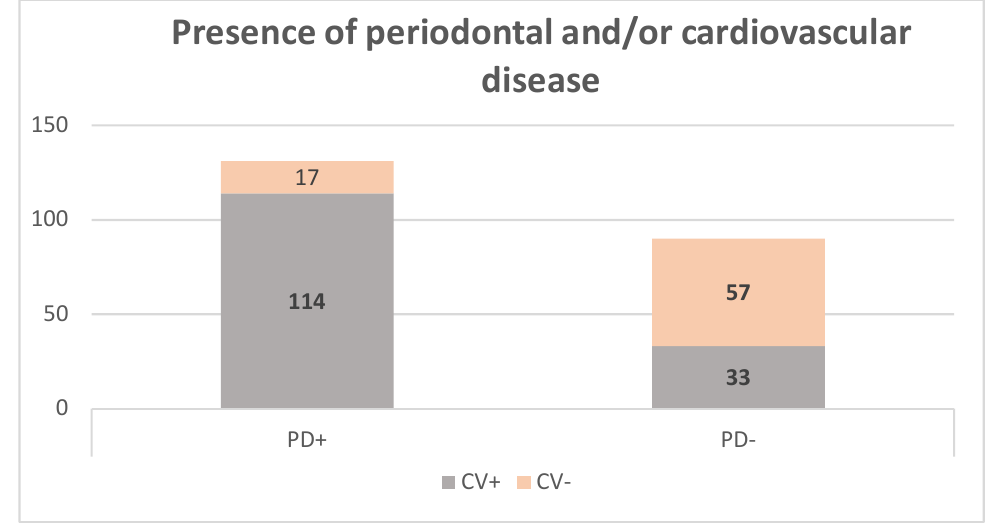
Figure 2. Distribution of periodontal disease and cardiovascular disease in the study group (CV+ patients with cardiovascular disease, CV− without cardiovascular disease, PD+ with periodontal disease, PD− without periodontal disease).